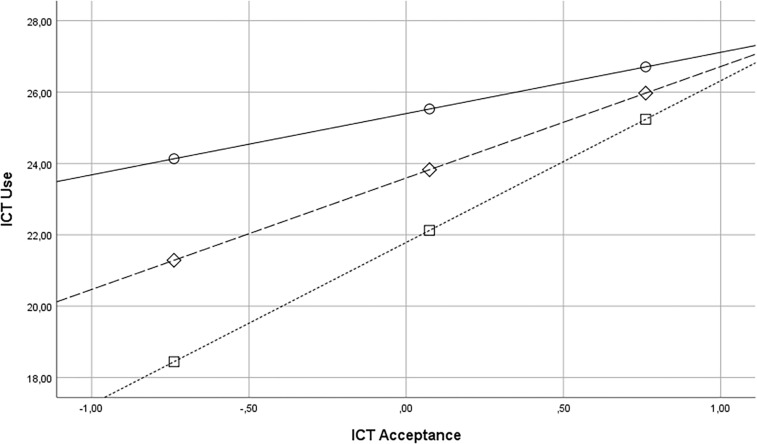
Relationship between ICT Acceptance (mean centered) and ICT Use diminishes with increasing levels of NC (mean centered). Regression lines for low NC (square, dot), b = 4,53, t = 4,79, se = 0,95, p < 0.001, medium (diamond, dash), b = 3,12, t = 3,77, se = 0,83, p < 0.001, high (circle, line), b = 1,72, t = 1,4, se = 1,2, p > 0.05.